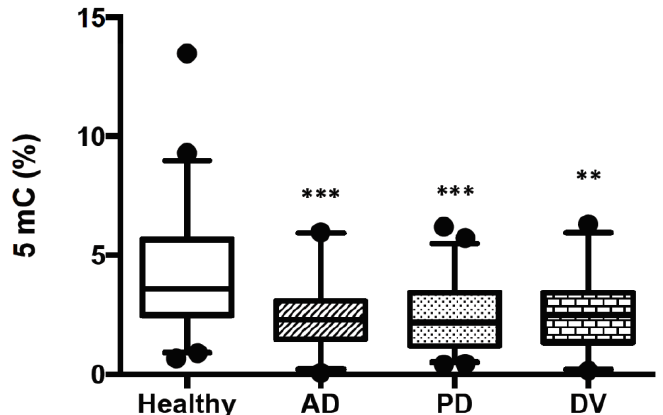
Figure 1. 5mC levels in blood DNA samples from healthy subjects and patients with AD, PD or DV. DNA global methylation was determined with an Enzyme-Linked ImmunoSorbent Assay (ELISA)-like colorimetric assay as described in Material and Methods. The study includes 40 patients with AD, 35 with PD, 26 with DV and 40 healthy controls. Data are shown in a box-plot graphic. Statistical significance between groups was calculated with ANOVA and the Bonferroni test and is shown as ** p < 0.01 and *** p < 0.001.